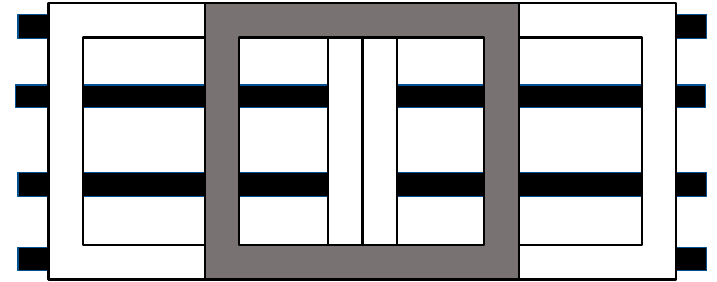
Figure 5. Simplified layout of the quadrature double D (DDQ) magnetic coupler [32].